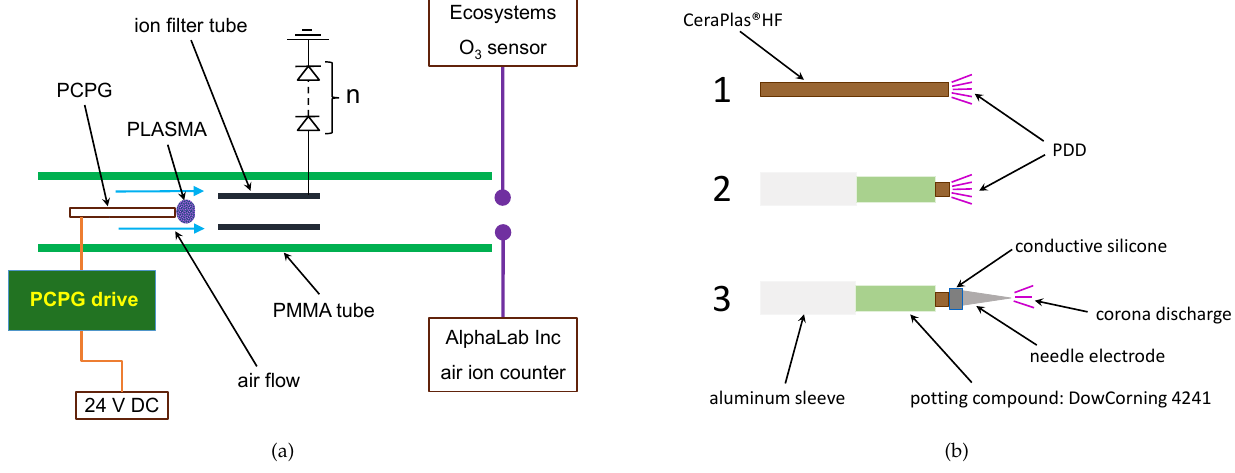
Figure 1. Setup for measurement of ion and ozone concentration. ( a ) Geometry of the measurement system. ( b ) Three configurations of piezoelectric cold plasma generator (PCPG) 1 non-potted CeraPlas™HF, 2 potted CeraPlas™HF, and 3 CeraPlas™HF driven corona